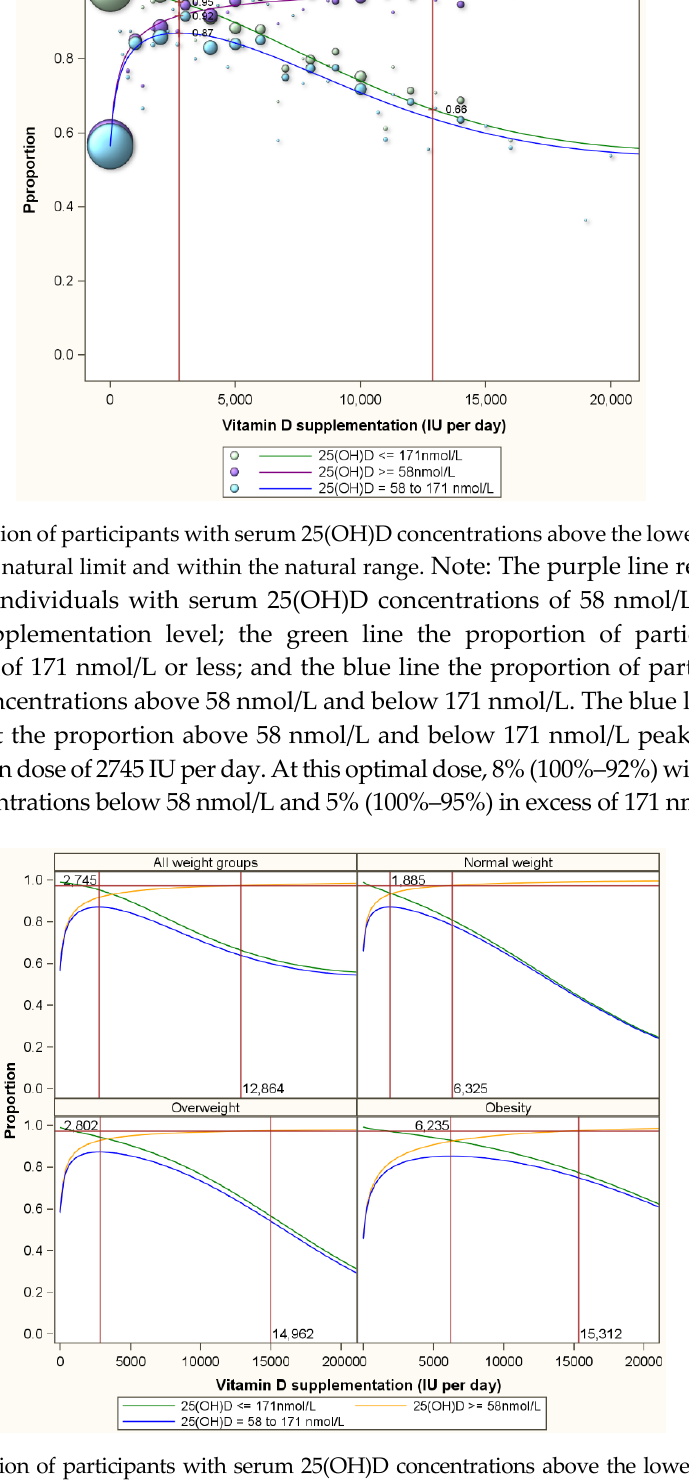
Figure 4. Proportion of participants with serum 25(OH)D concentrations above the lower natural limit, below the upper natural limit and within the natural range by body weight status. Note: The orange lines represent the proportion of individuals with serum 25(OH)D concentrations of 58 nmol/L or more by vitamin D supplementation level; the green lines the proportion of participants with concentrations of 171 nmol/L or less; and the blue lines the proportion of participants that have serum concentrations above 58 nmol/L and below 171